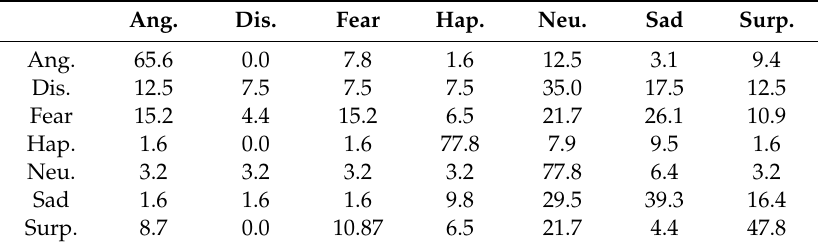
Table 4. The confusion matrix of VSHNN with FS module for AFEW dataset. Ang. Dis. Fear Hap. Neu. Sad Surp. Ang.